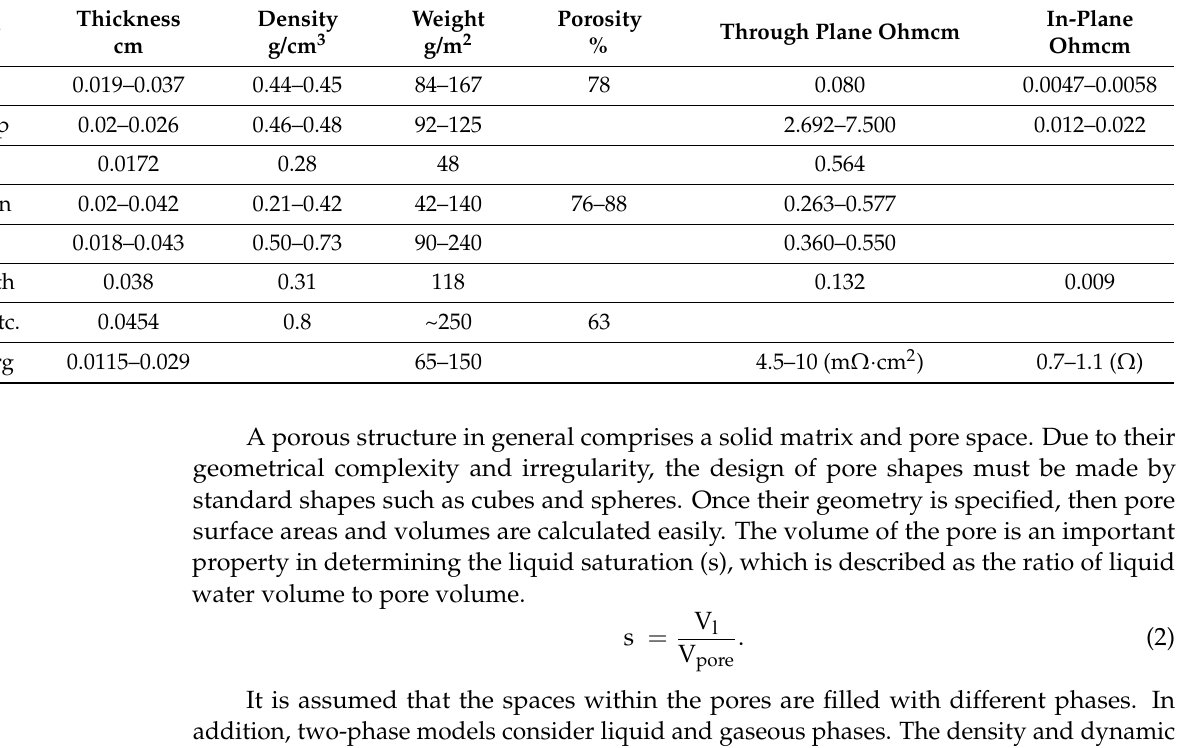
Table 3. GDL Manufacturers and Products (Adapted from